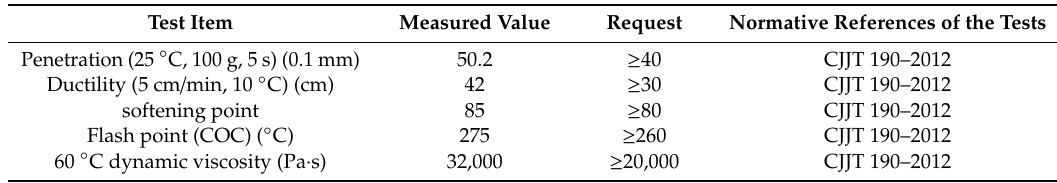
Table 3. Main technical indicators of the asphalt.